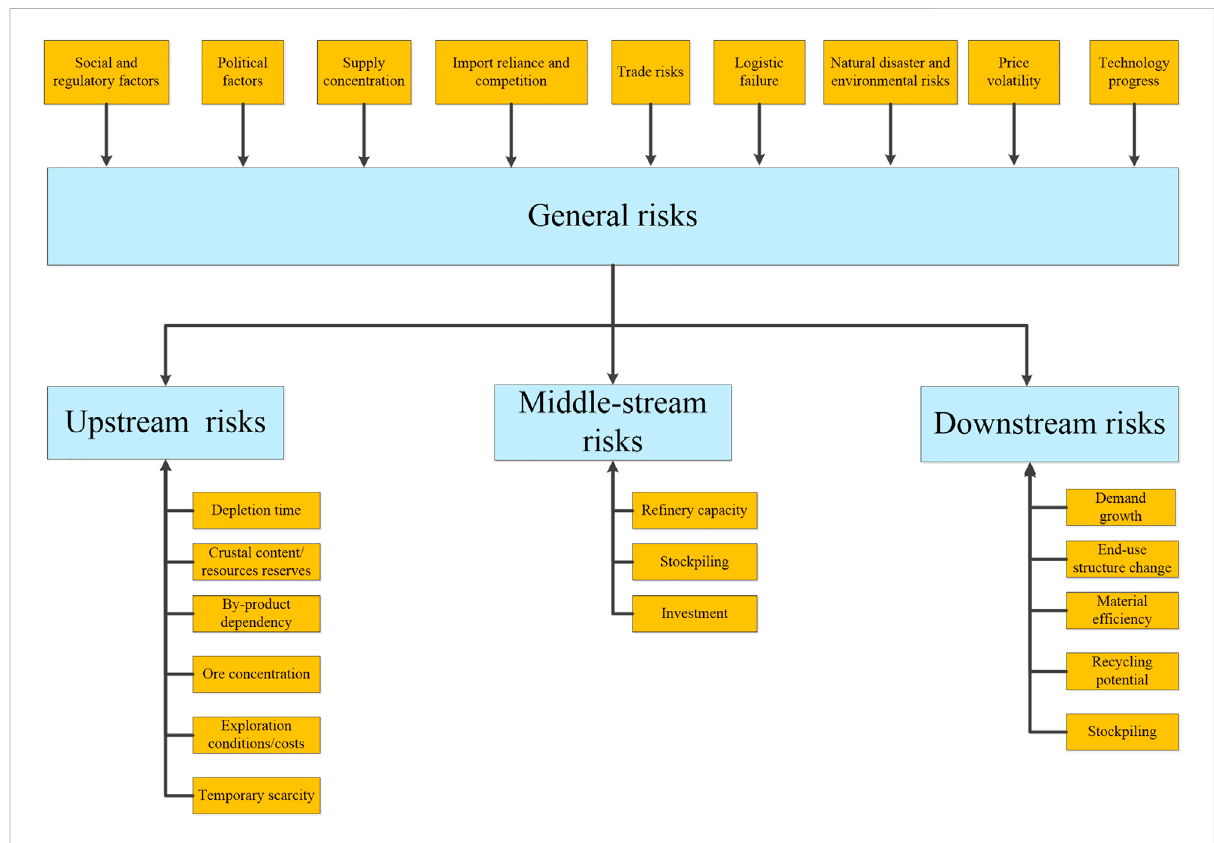
FIGURE 2 Framework for the supply chain risk